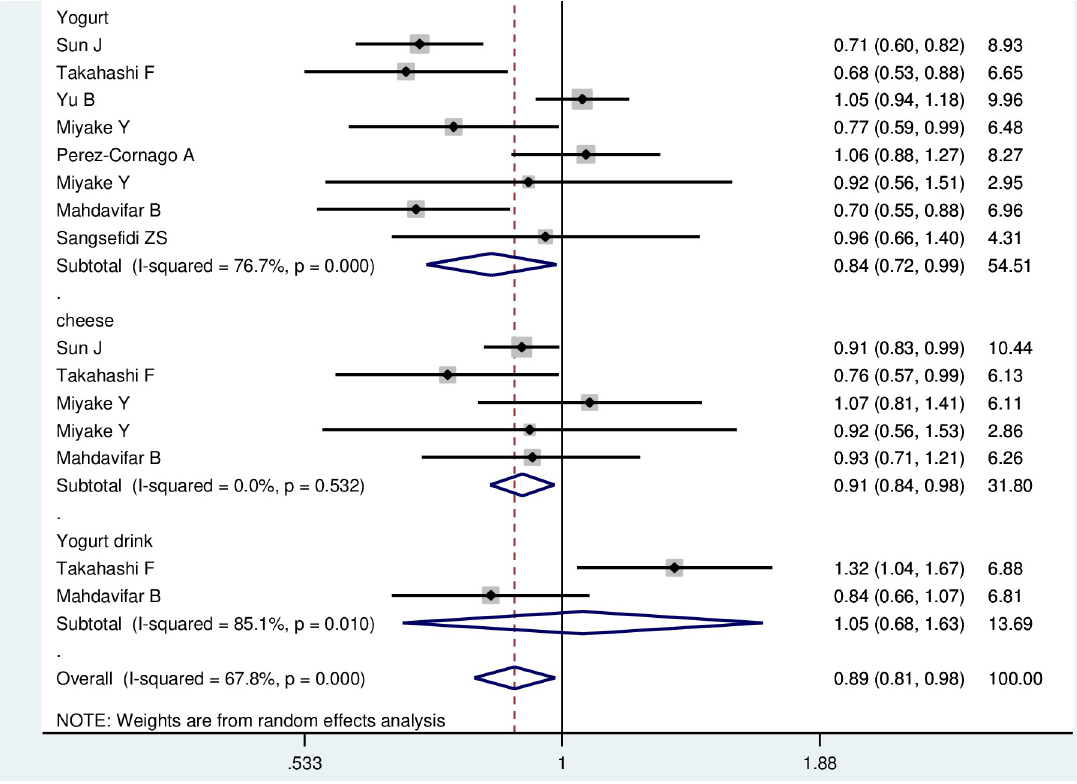
Fig 2. Forest plot of depression risk associated with fermented dairy